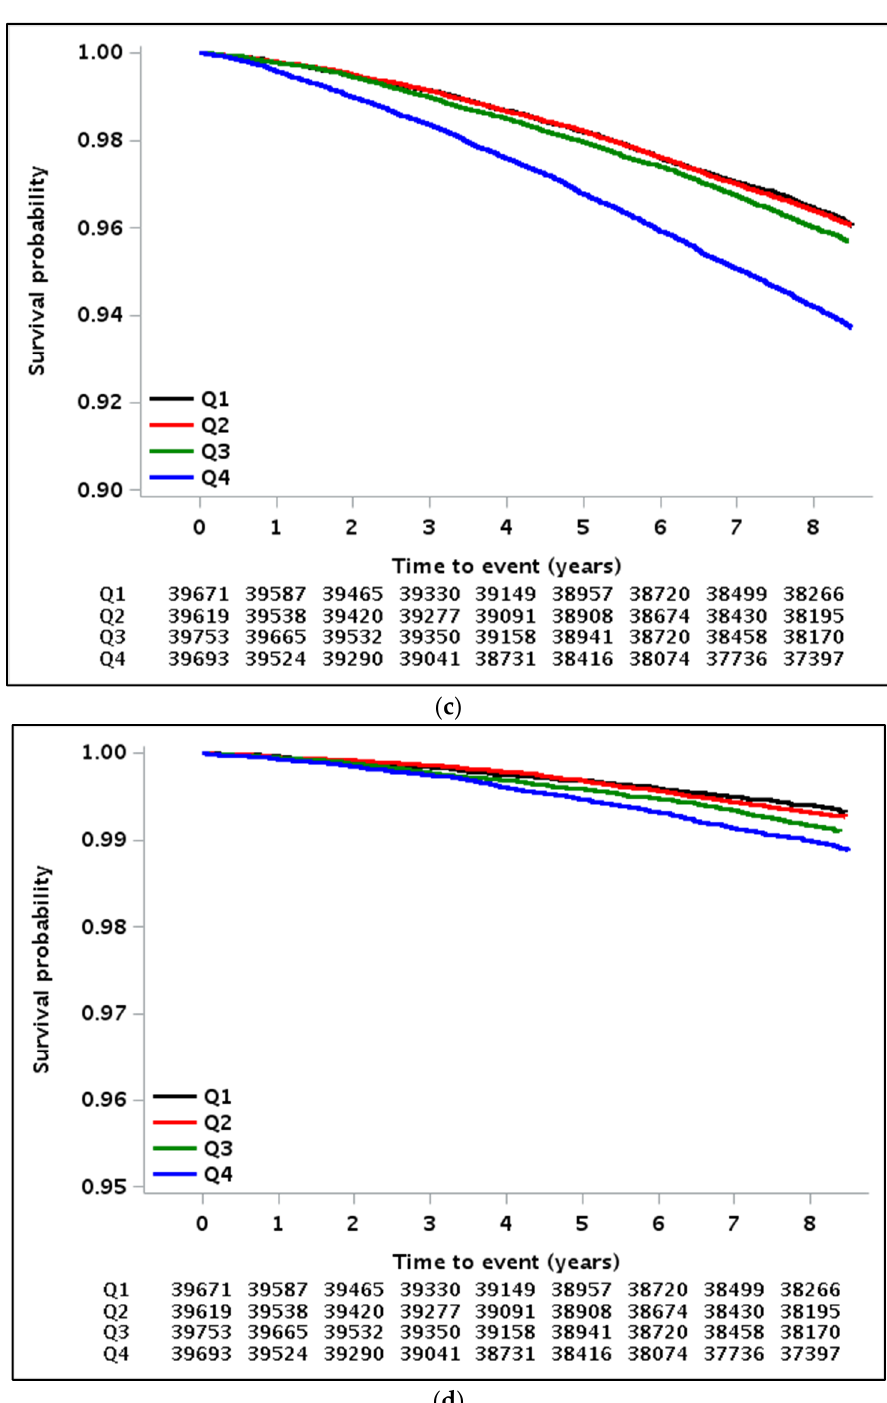
Figure 2. Kaplan–Meier estimates of survival and disease-free probability expressed as quartiles of γ-glutamyltransferase (GGT) variability measured as the coefficient of variance: ( a ) Myocardial infarction, ( b ) stroke, ( c ) all-cause mortality, and ( d ) cardiovascular disease-related mortality.